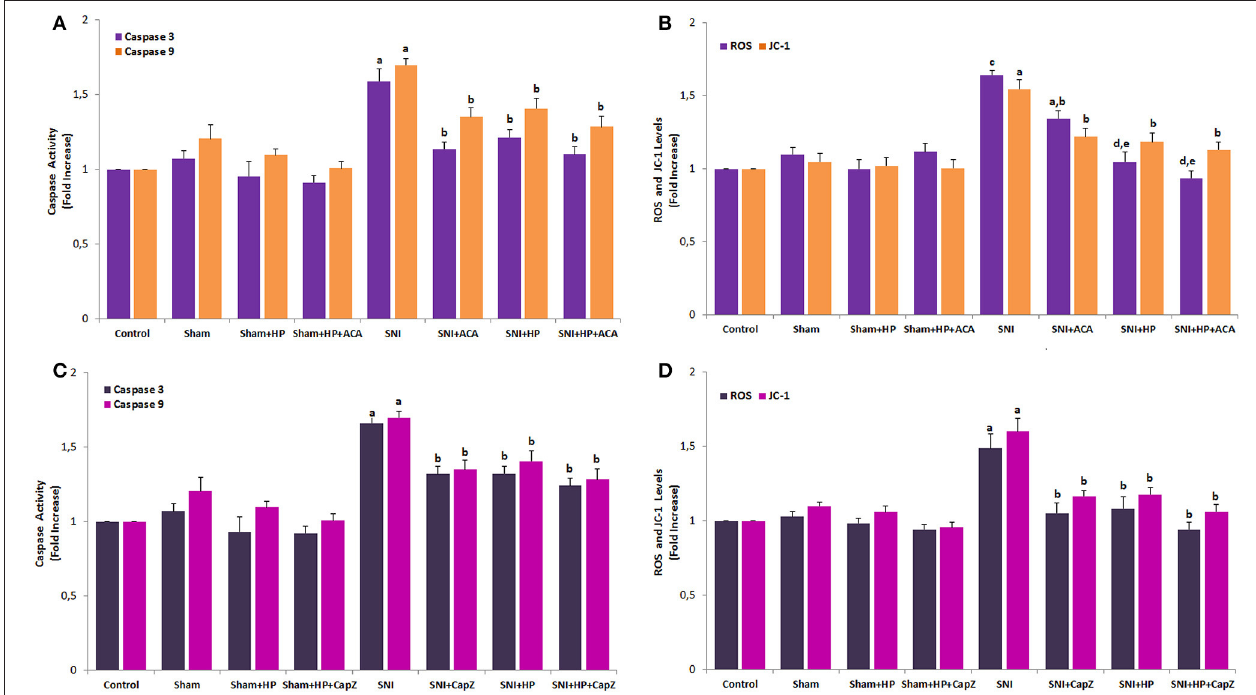
FIGURE 7 | Effects of Hypericum perforatum (HP) on the intracellular ROS production and cell mitochondrial membrane depolarization (JC-1) levels through TRPM2 (A,C) and TRPV1 (B,D) in sciatic nerve of SNI-induced rats (mean ± SD and n = 3). Values expressed as fold increase (experimental/control). Sciatic neurons were dissected from control, SNI and HP treated animals. The neurons in TRPM2 and TRPV1 experiments were stimulated with cumene hydroperoxide (CPx and 0.1 mM) capsaicin (CAPS and 0.01 mM) although they were inhibited by ACA (0.025 mM) and CapZ (0.1 mM), respectively. ( a p ≤ 0.05 and c p ≤ 0.001 vs. control, sham, sham + HP, sham + HP + ACA and sham + HP + CapZ groups. b p ≤ 0.05 and d p ≤ 0.001 vs. SNI group. e p ≤ 0.05 vs. SNI + ACA group).